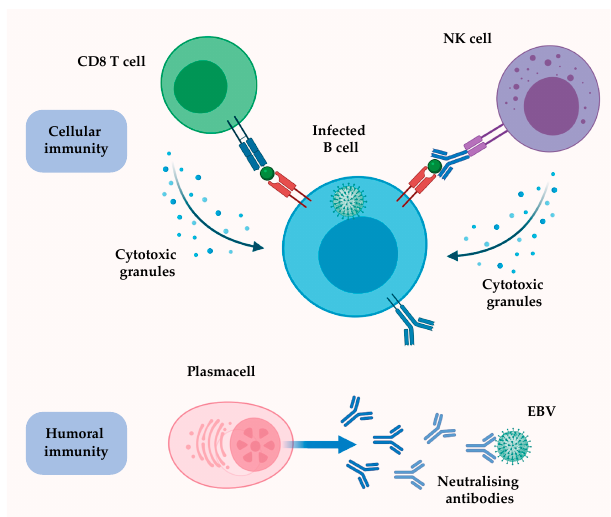
Figure 2. The targeting of EBV-infected cells and EBV virions by the adaptive immune system. EBV-infected B cells that display viral antigens on major histocompatibility (MHC) molecules are recognized by cytolytic T cells (CD8 T cells), which release cytotoxic granules (e.g., perforin and granzymes) and trigger apoptosis in infected cells. The binding of antibodies to glycoproteins at the surface of replicating cells enable their recognition and elimination by natural killer (NK) cells through antibody dependent-cellular cytotoxicity (ADCC). Humoral immunity prevents the spreading of the infection to other B cells of the host by targeting EBV virions through neutralising antibodies. Credits: Created with BioRender.com.